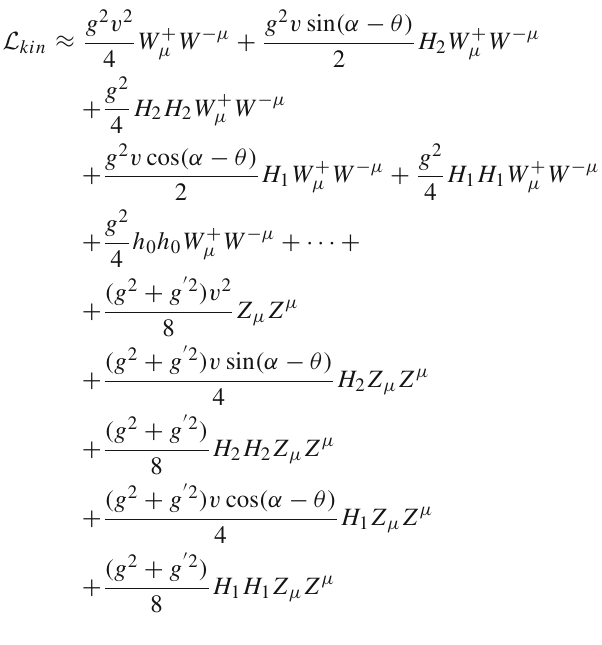
Table 1 Z 2 parity assignment for the physical states h 0 , A 1 , 2 and H ± and the intermediate-basis states ˜ H , and ˜ H b . In the alignment limit the last two will correspond also to the physical states Neutral